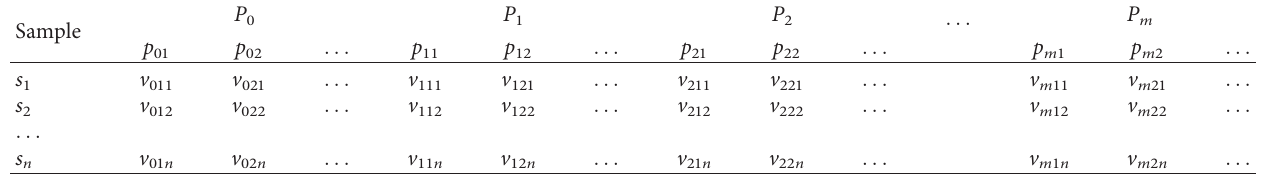
Table 1: Information table formed by combing microarray data with pathway knowledge. P Sample